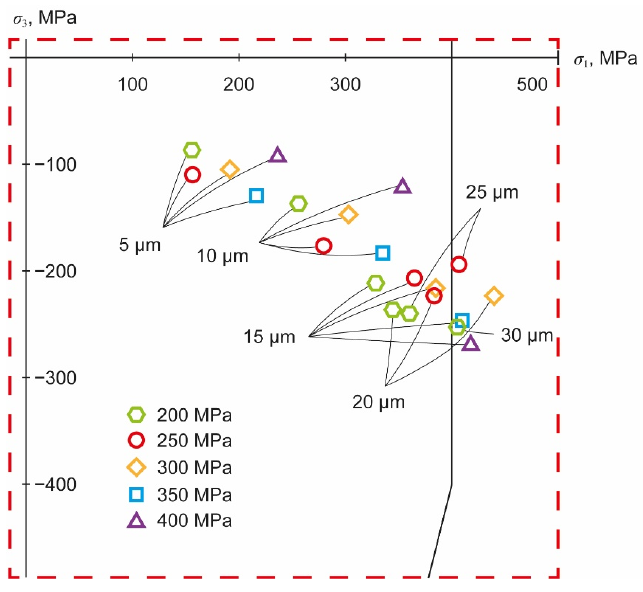
Figure 18. The tensile stresses at the impact of iron–aluminum silicate particles at different operating pressures on the surface of a c -axis aligned sapphire; see main text for details.